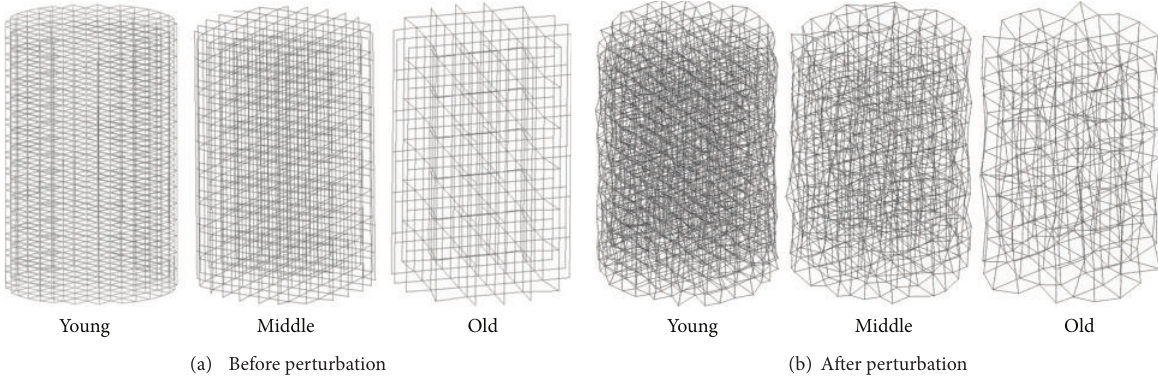
Figure 1: Lattice models with a trabecular structure before and after perturbation for three age groups—young ( < 50 years); middle (50 through 75 years); and old ( > 75 years).